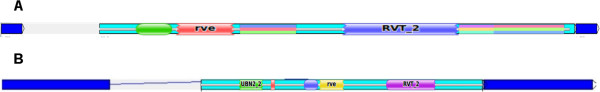
Annotation of Tos17 and RIRE1. Long terminal repeats (LTR) are symbolized in dark blue and the open reading frame (ORF) in light blue. (A)Tos17 annotation. The gag_pre-integrase (green), rve (red) and RVT_2 (blue) motif positions are reported on the ORF. (B)RIRE1 annotation. The UBN2_2 (green), Zf-CCHC (red), gag_pre-integrase (blue), rve (yellow) and RVT_2 (purple) motif positions are reported on the ORF.